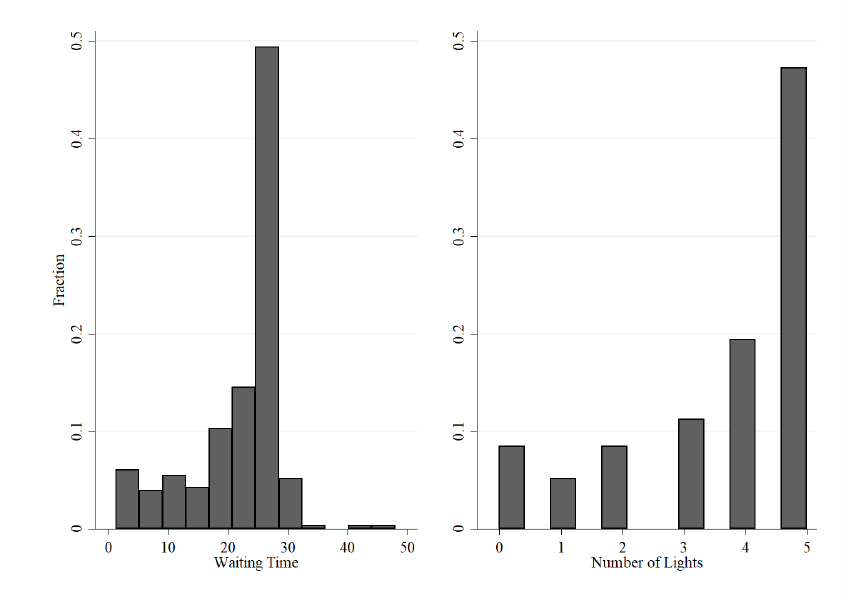
Figure 3. Histogram of behavior in the rule-following task. Note: Waiting Time is measured as the total number of seconds that a subject waited at each of the five lights. Number of Lights is equal to the number of lights subjects waited at until the light turned